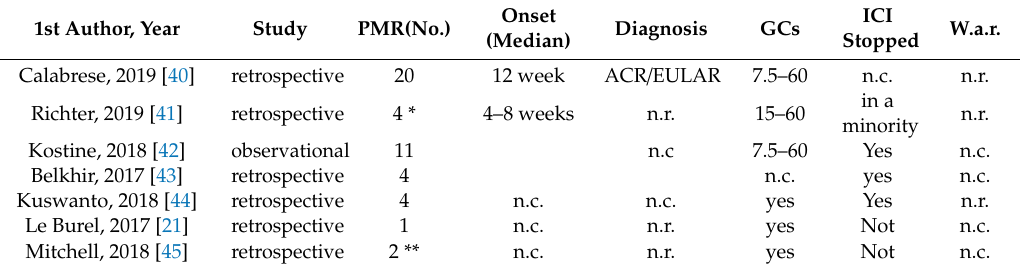
Table 2. IRAEs-PMR case-series and clinical studies included in our